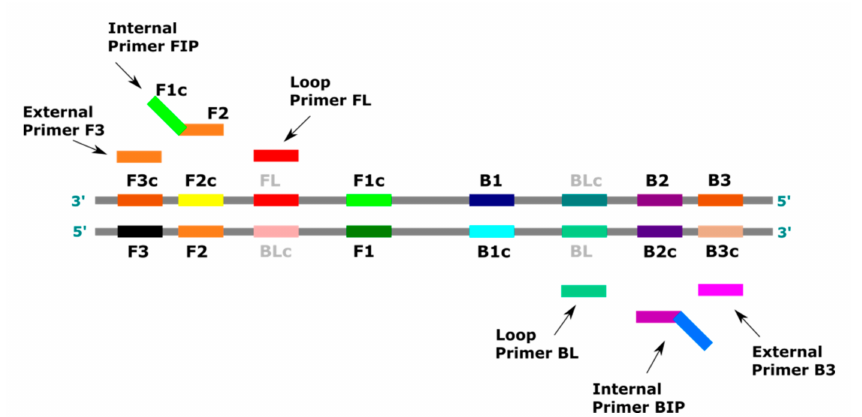
Figure 1. Primers used in the LAMP reaction. FIP (forward internal primer) contains a region F2 complementary to F2c of the matrix, and a free region F1c complementary to F1 on the newly- formed strand; BIP (backward internal primer) contains a region B2 complementary to B2c of the template, and a free region B1c complementary to B1 on the newly-formed strand; F3 (forward external primer) contains a region F3 complementary to F3c of the template; B3 (backward external primer) contains the region B3 complementary to B3c of the template; FL (forward loop primer) is complementary to the single-stranded loop between regions F2 and F1; BL (backward loop primer) is complementary to the single-stranded loop between regions B2 and B1. (Based on http: //loopamp.eiken.co.jp/e/lamp/primer.html (accessed on 1 June